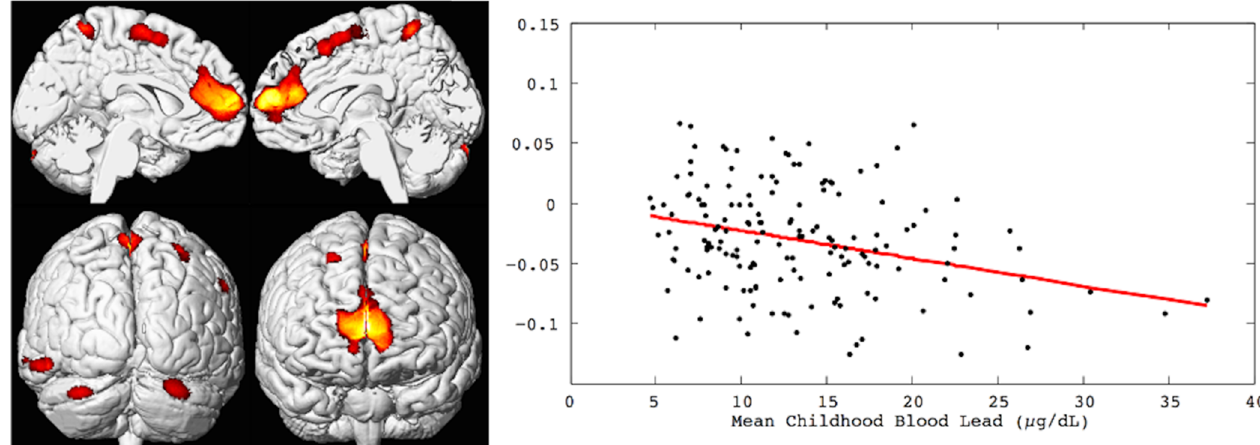
Figure 1. Left, the brain renderings illustrate the regional gray matter volume loss inversely associated with the mean childhood blood lead concentrations (derived from 23 assessments at ages 3 to 78 months) with covariates from the Cincinnati Lead Study. The population imaged includes 157 adults ages 19 to 24 years imaged at 1.5 Tesla. Right, the linear dose-dependent relationship of individual regional brain volume plotted with the mean childhood blood lead concentration within the medial frontal cluster. The multiple linear regression model accounts for age at time of imaging and birth weight.